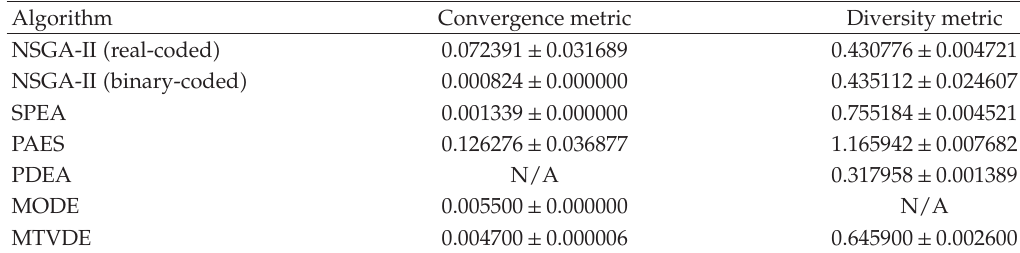
Table 2: Testing result’s statistics of the problem ZDT2.